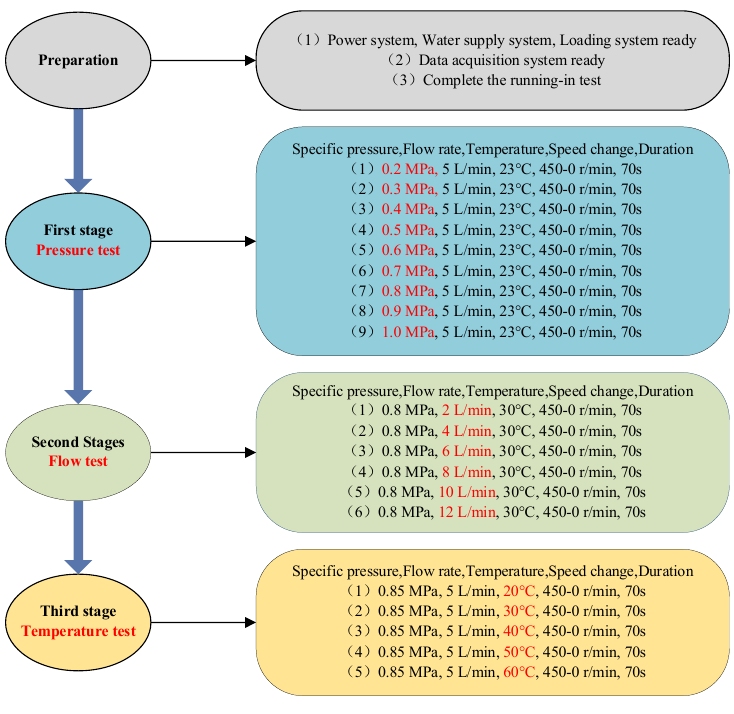
Figure 9. Test flow.